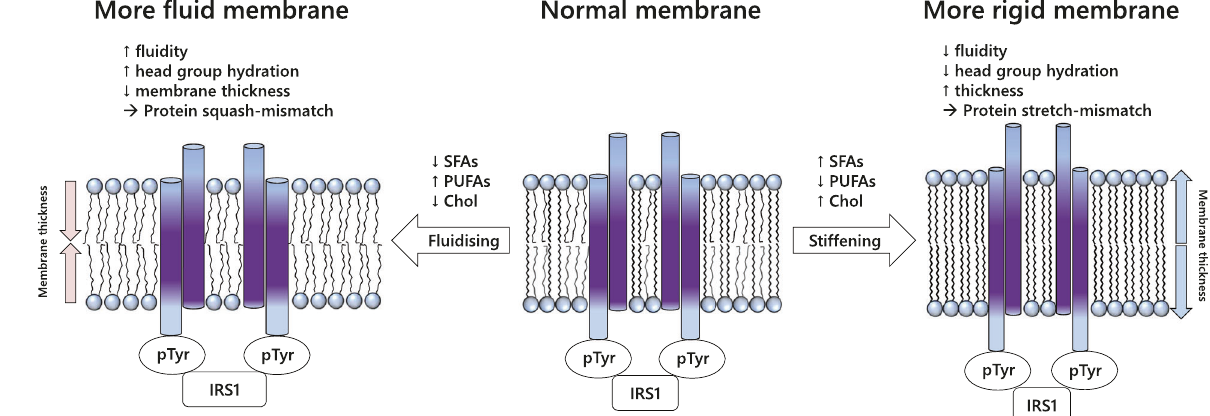
Fig. 7 Summary of the hypothesis that the increased risk of CVD/T2DM associated with obese GDM is associated with altered lipid